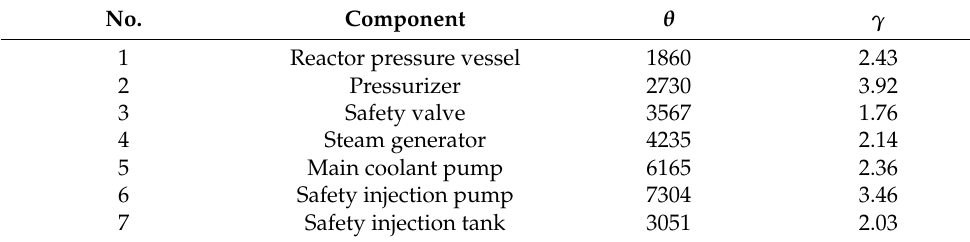
Table 1. Scale and shape parameters of each component.